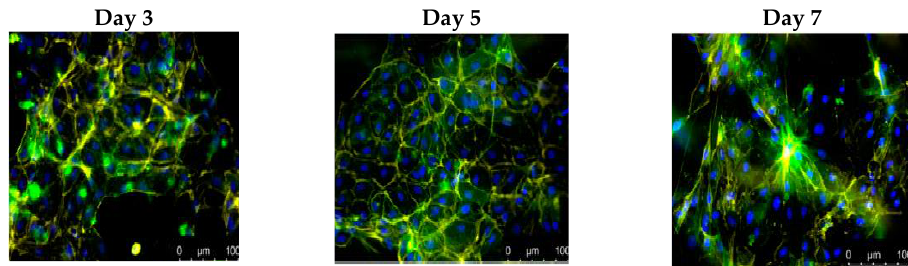
Figure 18. Fluorescent images of VECs on top layer of the VECs-VICs co-culture model β 1 Integrin—green; F-actin—yellow; Nuclei—blue; Cell membrane—red (scale bar: 100 µ m). Adapted with permission from ref. [231]. Copyright 2018, MDPI.